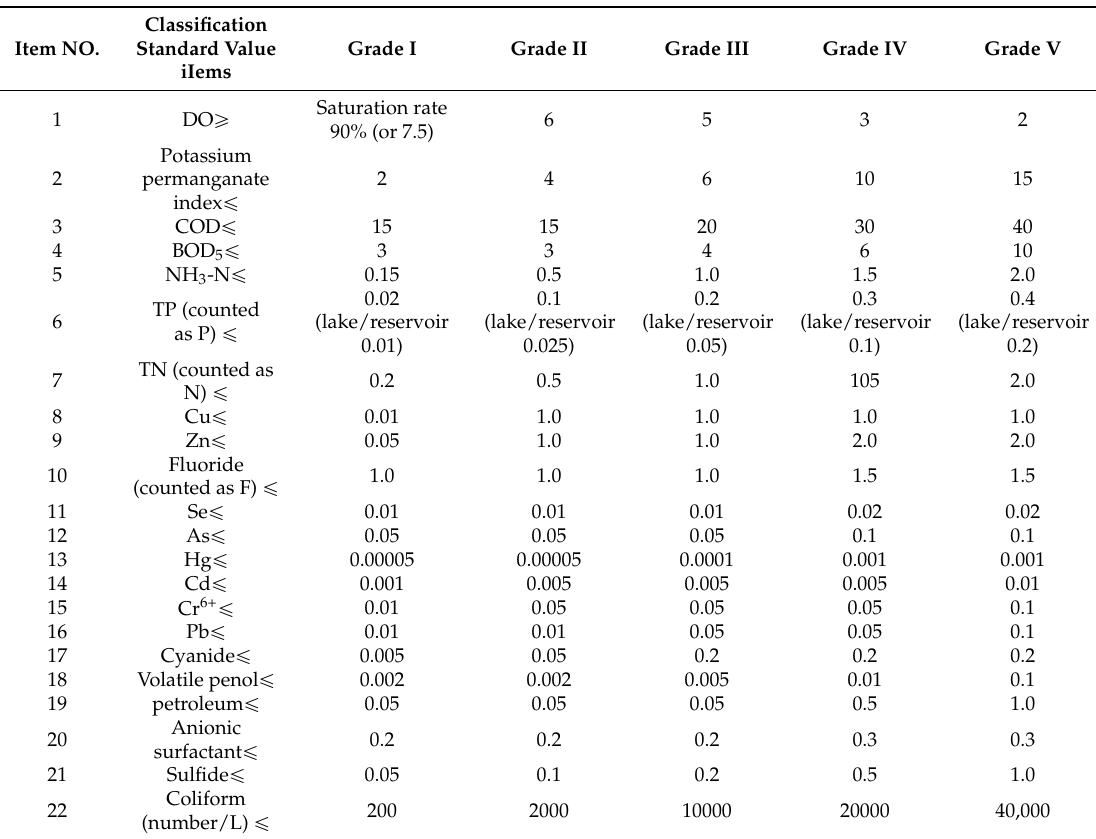
Table A1. Environmental quality standards for surface water (GB3838-2002) (Main items). Unit in mg/L.